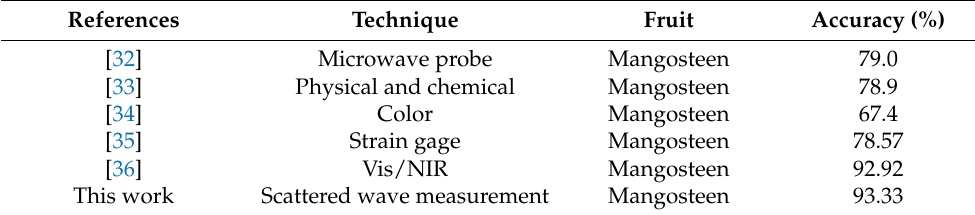
Table 1. Comparison of performance of mangosteen fruit grading